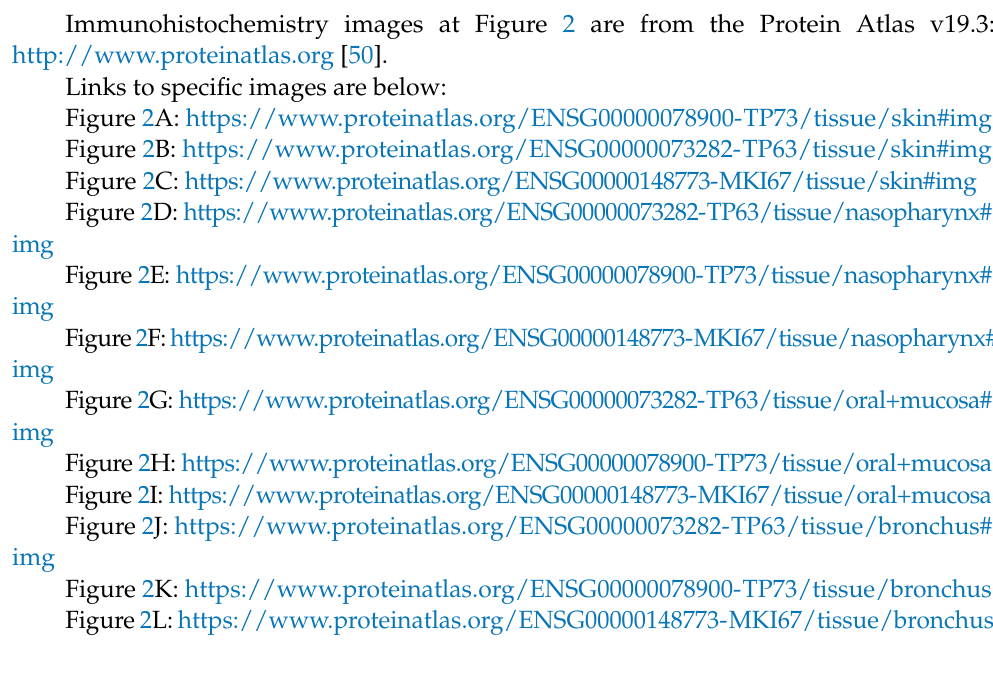
Figure 2A: https://www.proteinatlas.org/ENSG00000078900-TP73/tissue/skin#img Figure 2B: https://www.proteinatlas.org/ENSG00000073282-TP63/tissue/skin#img Figure 2C: https://www.proteinatlas.org/ENSG00000148773-MKI67/tissue/skin#img Figure 2D: https://www.proteinatlas.org/ENSG00000073282-TP63/tissue/nasopharynx# img Figure 2E: https://www.proteinatlas.org/ENSG00000078900-TP73/tissue/nasopharynx# img Figure 2F: https://www.proteinatlas.org/ENSG00000148773-MKI67/tissue/nasopharynx# img Figure 2G: https://www.proteinatlas.org/ENSG00000073282-TP63/tissue/oral+mucosa# img Figure 2H: https://www.proteinatlas.org/ENSG00000078900-TP73/tissue/oral+mucosa Figure 2I: https://www.proteinatlas.org/ENSG00000148773-MKI67/tissue/oral+mucosa Figure 2J: https://www.proteinatlas.org/ENSG00000073282-TP63/tissue/bronchus# img Figure 2K: https://www.proteinatlas.org/ENSG00000078900-TP73/tissue/bronchus Figure 2L: